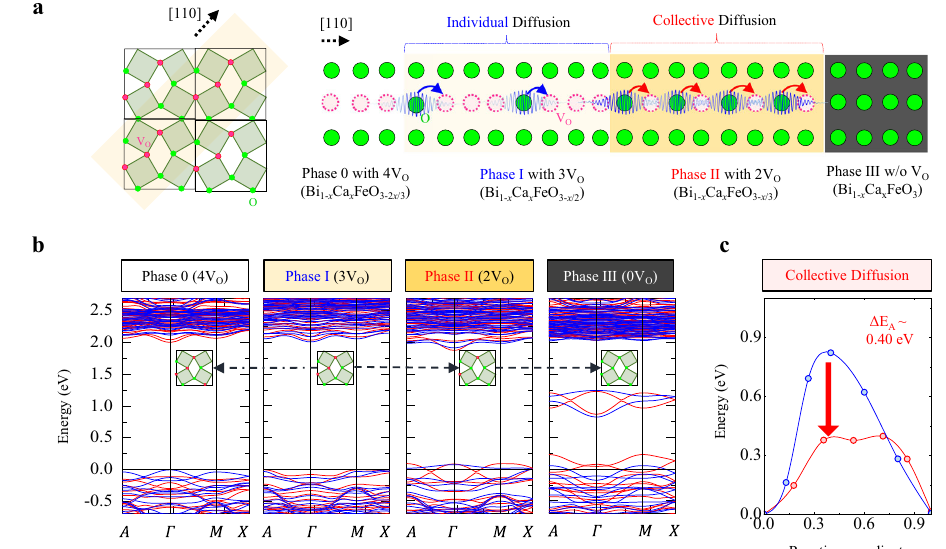
A =(0.5,0.5,0.5), Γ =(0.0,0.0,0.0), M =(0.5,0.5,0.0),and X =(0.5,0.0,0.0). c E